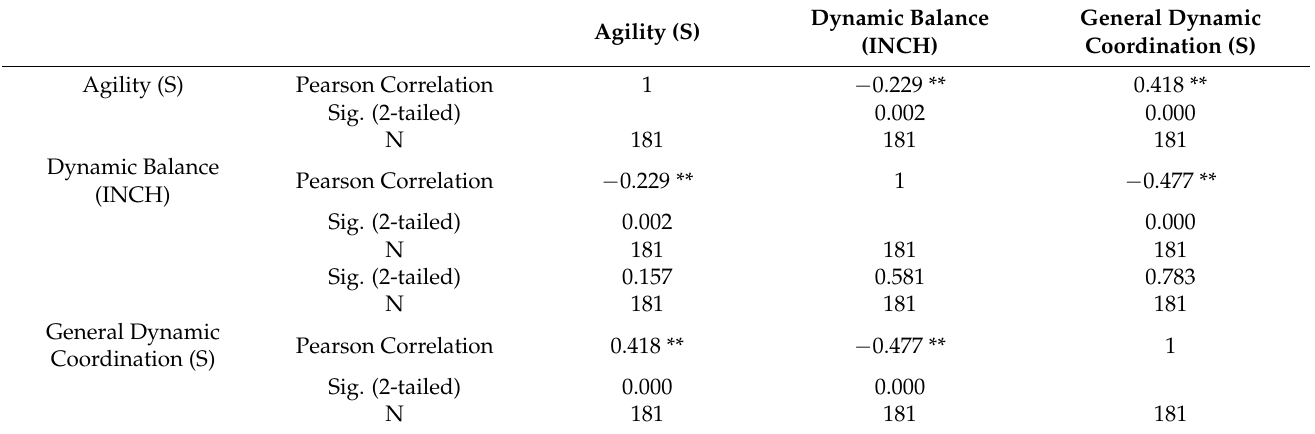
Table 4. Main correlations between psychomotor testing results.